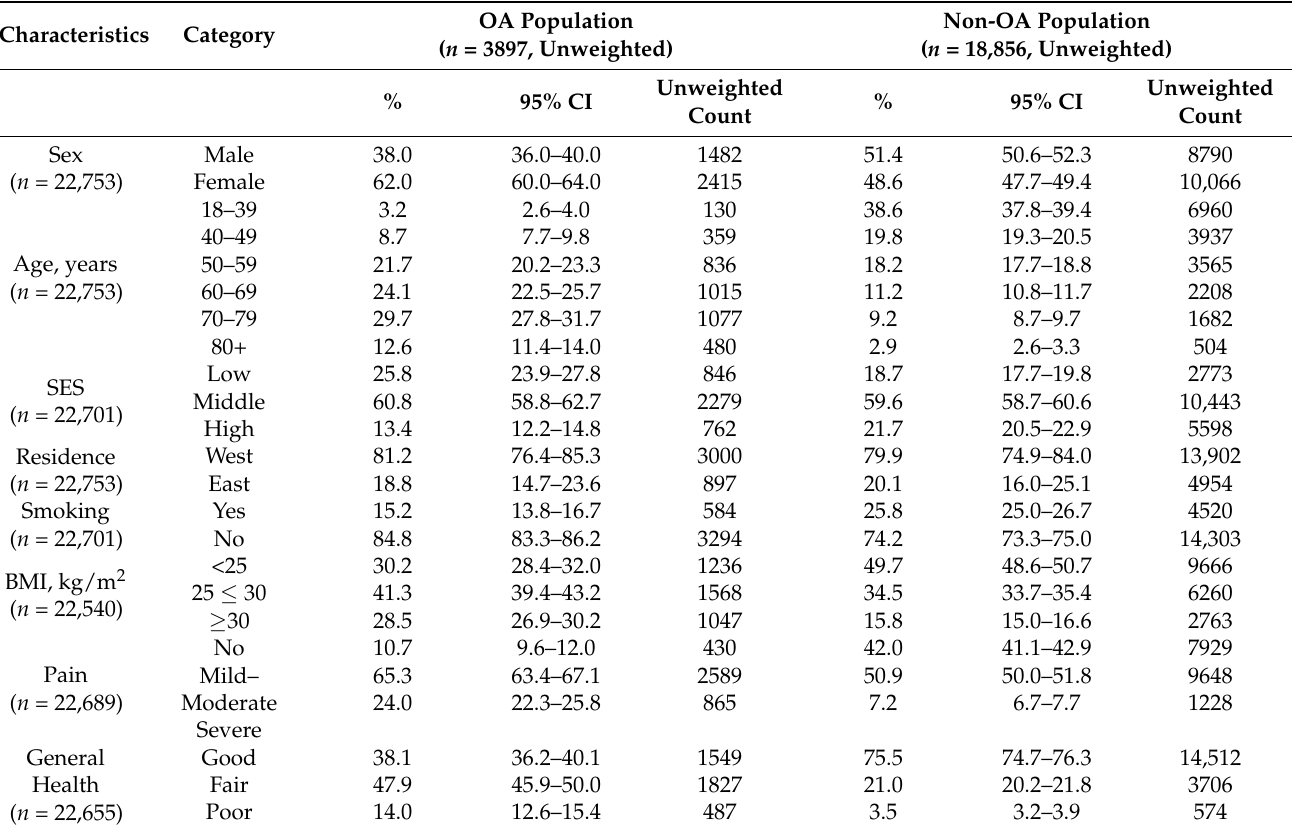
Table 1. Baseline characteristics according to OA ( n = 22,753, unweighted) in % (weighted) and 95% CI. Characteristics